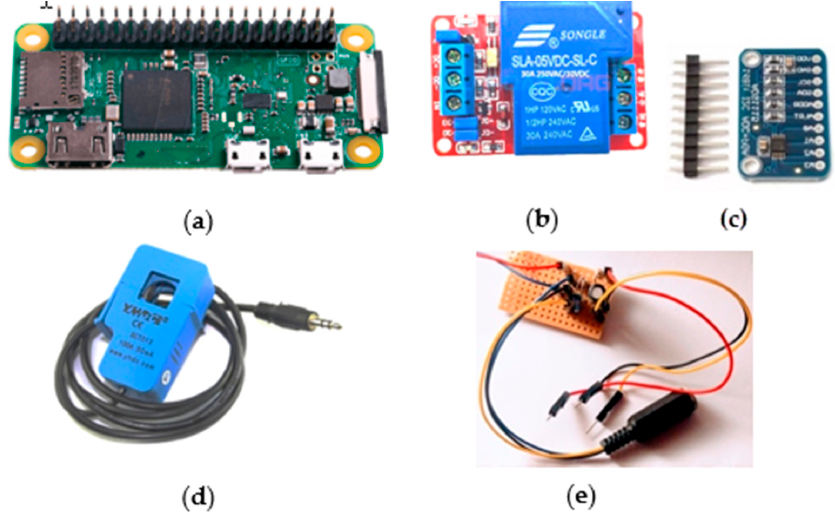
Figure 17. Main hardware components for the charging station (CS). ( a ) Raspberry PI Zero W; ( b ) ADS111 analog-to-digital converter 5; ( c ) SLA-05VDC-SL-C relay; ( d ) Current/tension converter; ( e ) SCT013 current transformer.